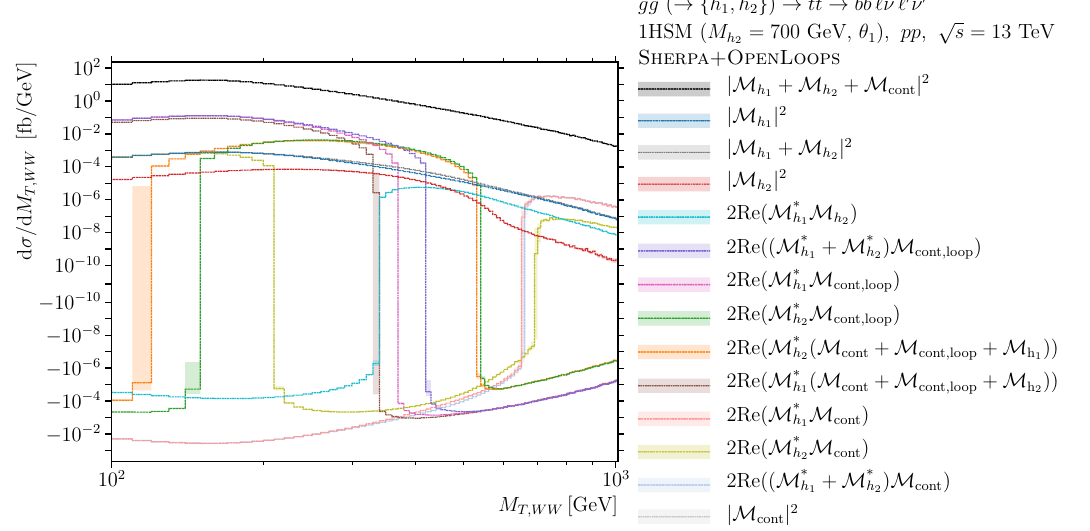
¯ t b ¯ b (cid:25) ¯ ν ¯ (cid:25) (cid:31) ν (cid:31) in →